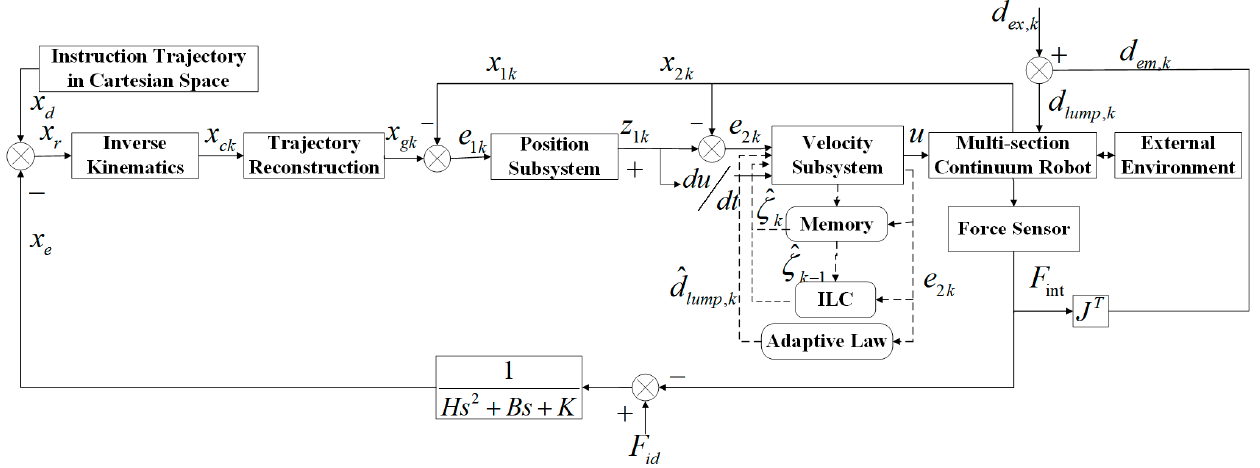
Figure 8. The control flow diagram of the proposed algorithm.